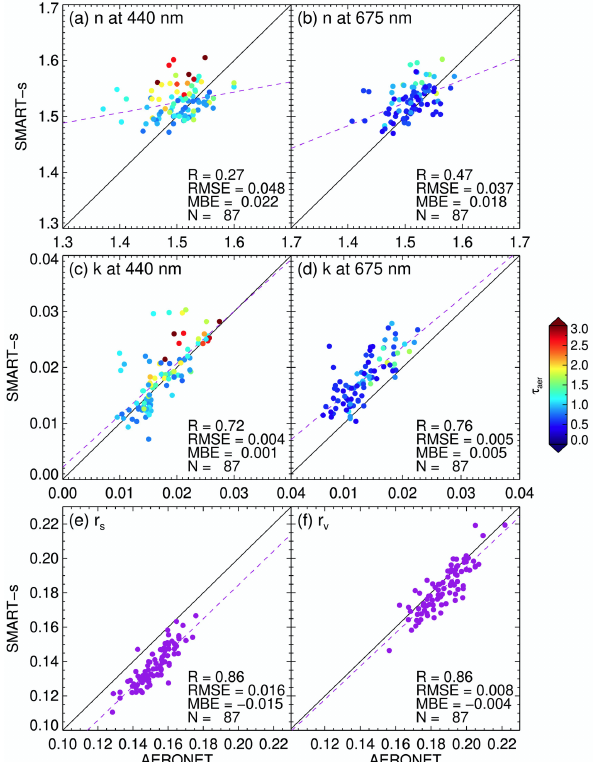
Figure D1. Comparison of aerosol inversion products from SMART–s and AERONET (version 3, level 2.0) from 19 March to 2 May 2019. Upper panels compare the real part of the refractive index at (a) 440nm and (b) 675nm, and middle panels compare the imaginary part at these wavelengths. Colored circles in panels (a) – (d) represent the values of aerosol optical thickness ( τ aer ) from the color bar at each wavelength. Lower panels compare (e) area- and (f) volume-weighted mean radii ( r s and r v , respectively). R is the correlation coefficient, RMSE denotes the root mean square error, MBE is the mean bias error, and N is the number of samples for the comparison. The black solid line and purple dashed line depict one-to-one and regressions,